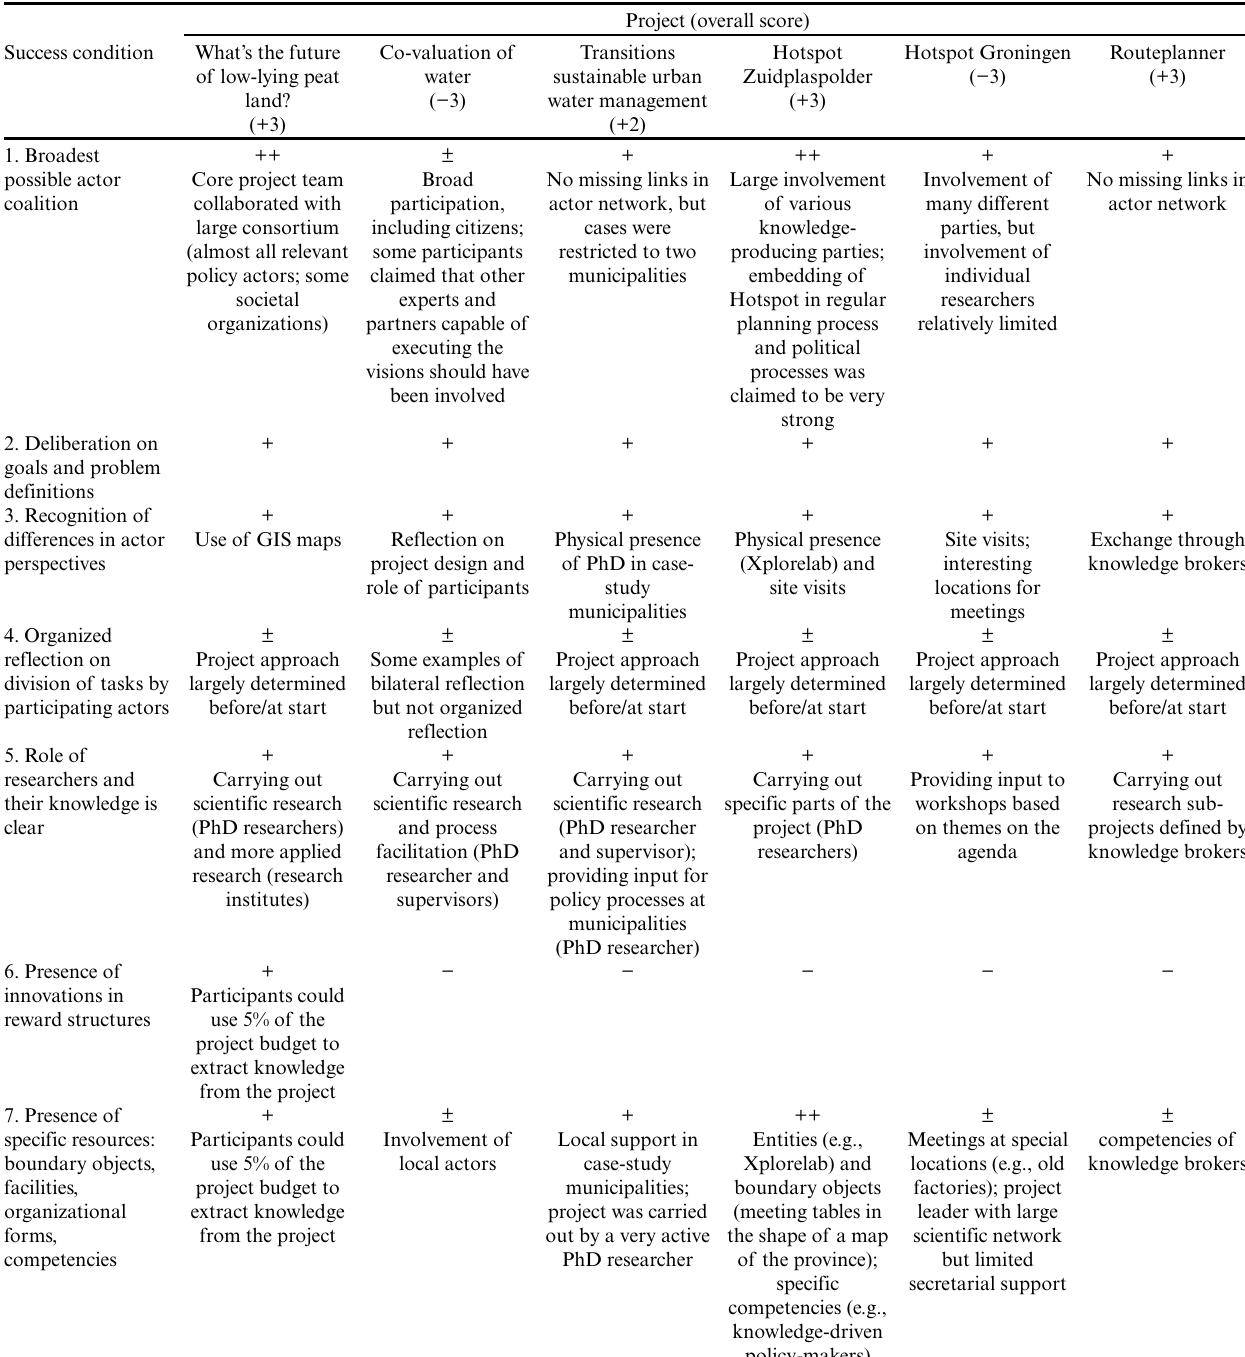
Table 6. Presence of success conditions in the projects.† the table also repeats the overall scores for success of table 5. Project (overall